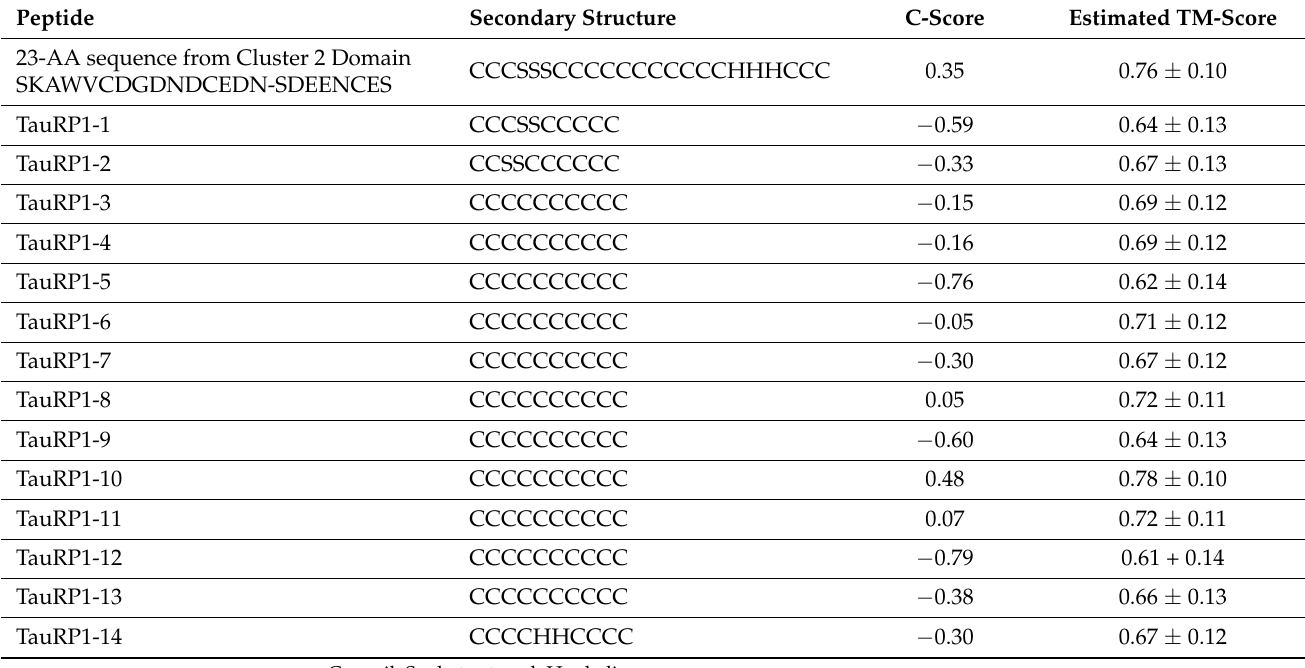
Table 3. Peptide secondary structures based on I-TASSER